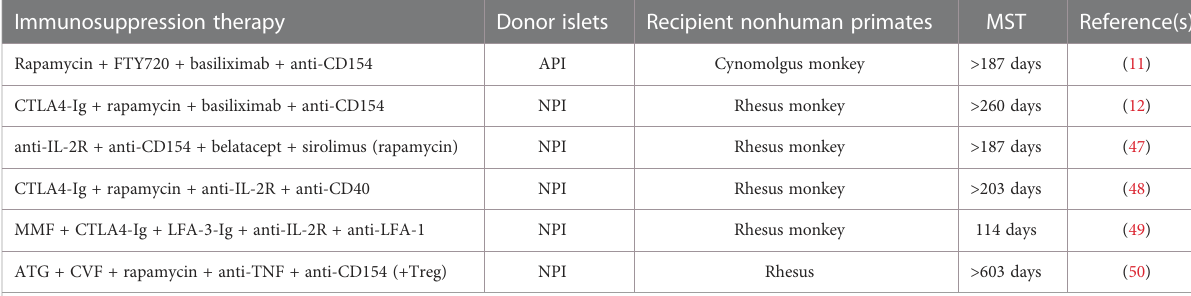
TABLE 1 Various immune suppression regimens used to increase islet